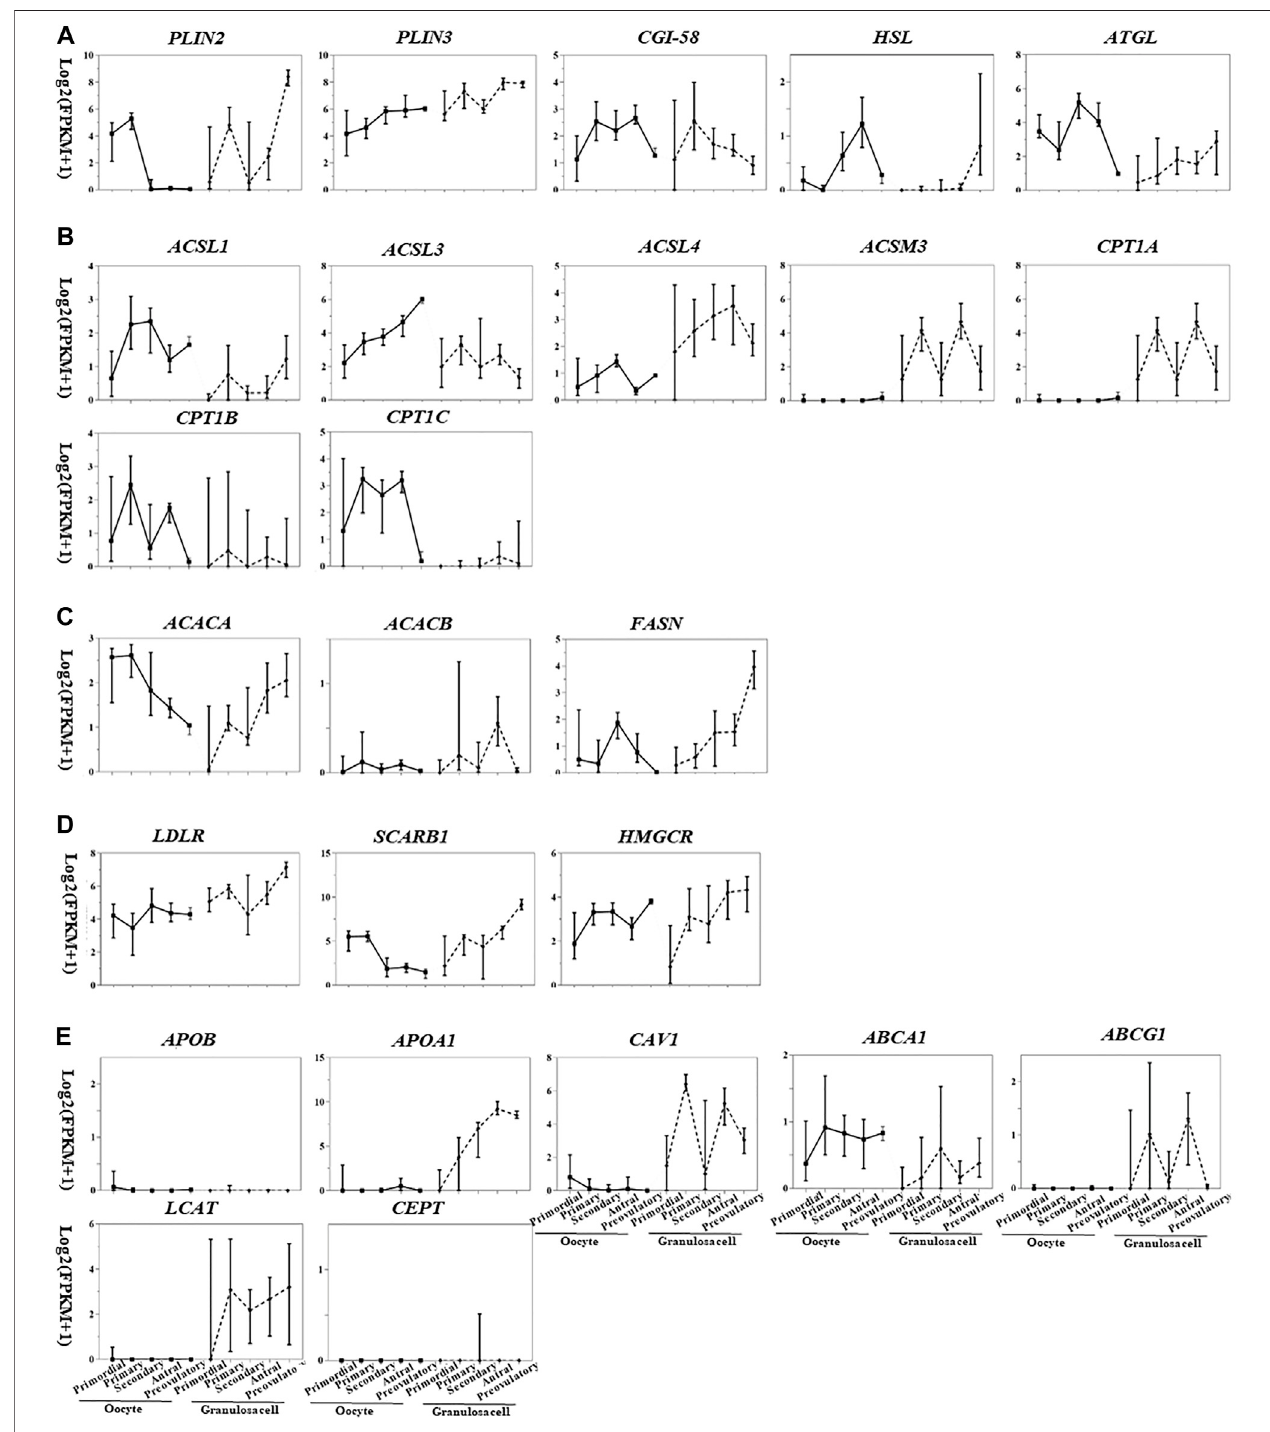
FIGURE2| Transcriptionalpatternoflipidmetabolism genesinoocytesandgranulosacellsduringfolliculogenesis[imagesourced from(Martinezetal.,2004)]. (A) Triglyceride breakdown; (B) fatty acid oxidation; (C) fatty acid synthesis; (D) lipoprotein transport and cholesterol uptake; (E) lipoprotein synthesis and remodeling.